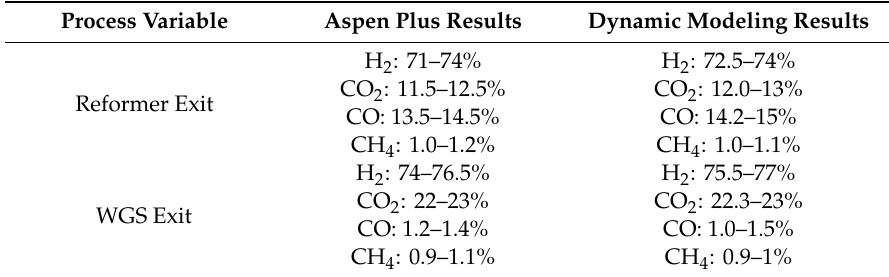
Table 2. Comparison of Aspen Plus and process modeling results (at steady state conditions). Process Variable Aspen Plus Results Dynamic Modeling Results